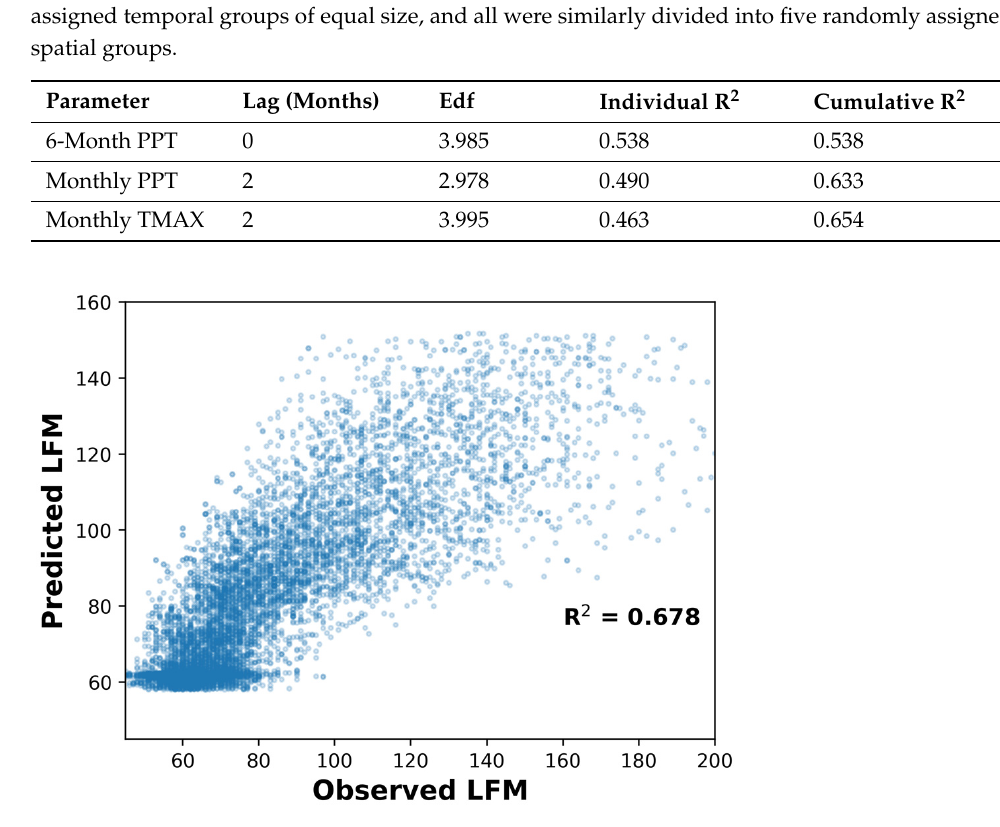
Figure 3. Smoothed coefficients of ( a ) cumulative precipitation over the prior six months, ( b ) monthly precipitation (2 month lag), and ( c ) mean maximum temperature (2 month lag) developed for GAM models used to predict LFM. Smoothed values ( y -axis) represent contributions of each parameter to estimated LFM throughout the observed parameter space ( x -axis). Solid red lines in- dicate smoothed coefficients. Dashed blue lines indicate 95% confidence intervals for each smoothed coefficient Both PPT and TMAX exhibited nonlinear relationships to LFM, with both 6 month and monthly lagged precipitation exhibiting strong positive relationships between PPT and LFM until reaching a saturation point, above which the relationship between precip- itation and LFM were weakened and reversed. However, the sharp increases in the mar- gins of error above these saturation points (roughly 800 mm in 6 month cumulative PPT and 350 mm in monthly PPT), implied a weak and nondeterministic relationship to LFM when PPT was high. In contrast, the relationship between LFM and TMAX remained strong throughout the entire observed temperature range, with low LFM predicted in as- sociation with low temperatures, reflecting winter dormancy, followed by high LFM